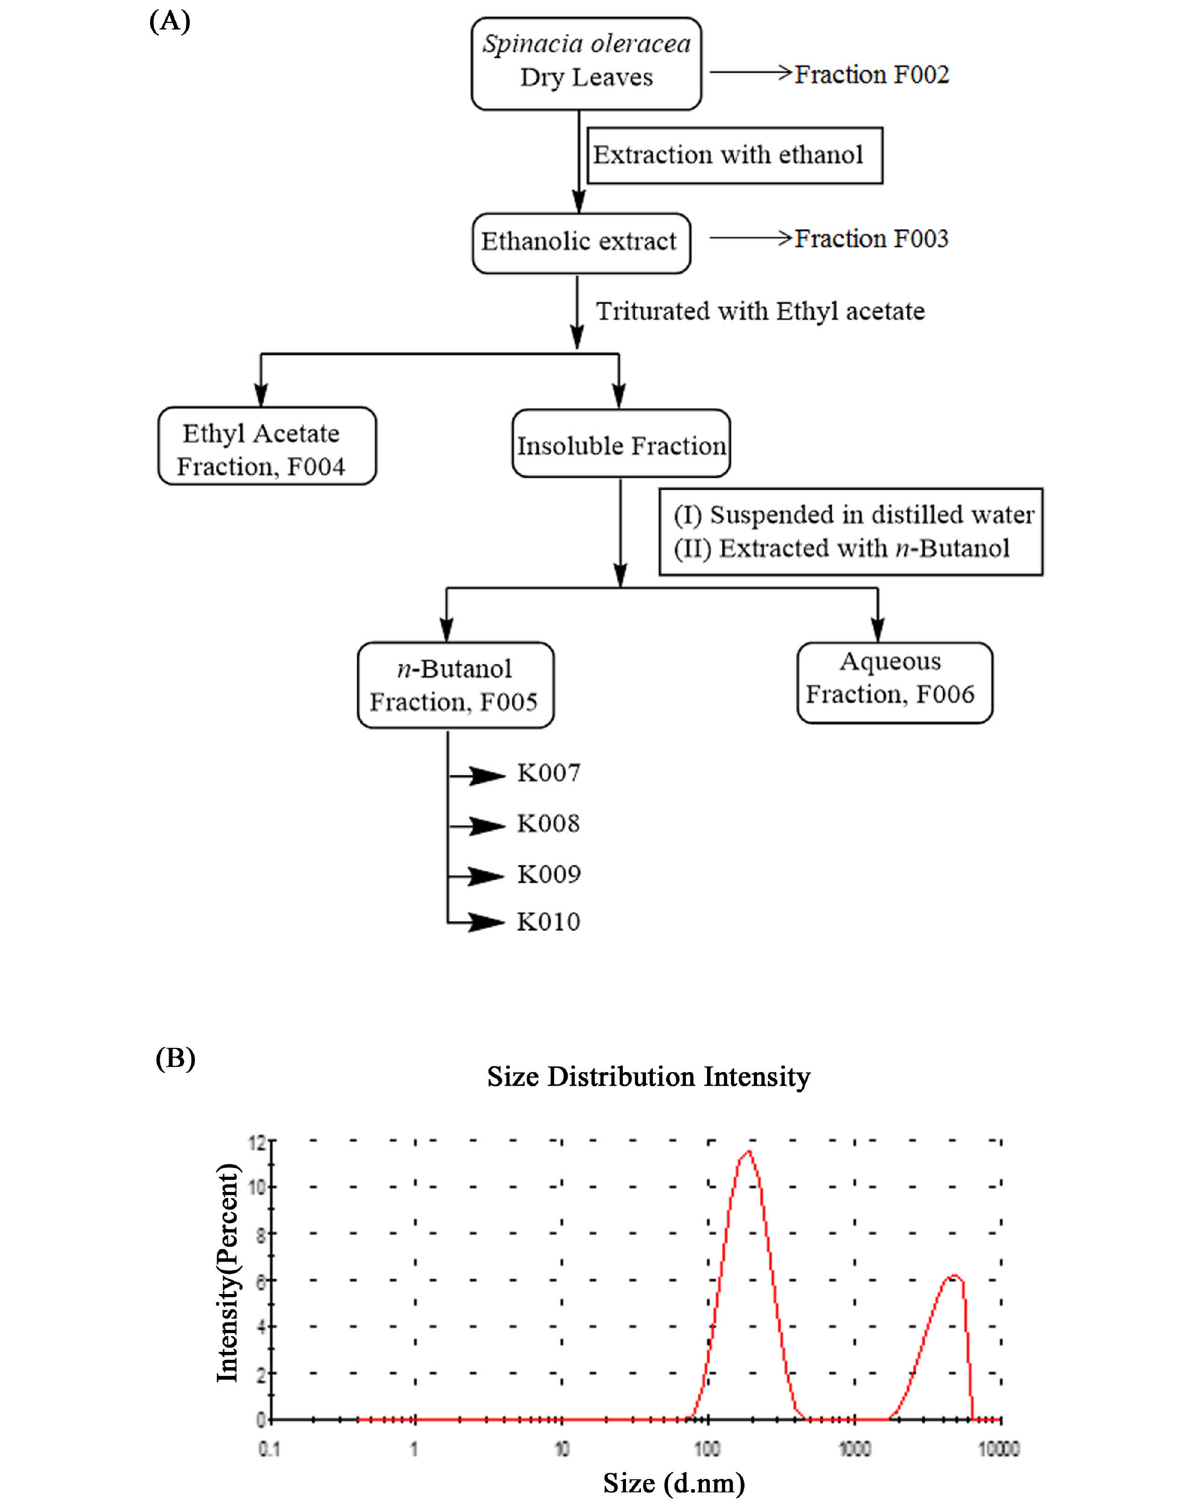
Fig. 1 a Fractionation procedure of dried leaves extract of Spinacia oleracea. b Particle size distribution of SEEDS formulation after diluting 1 in